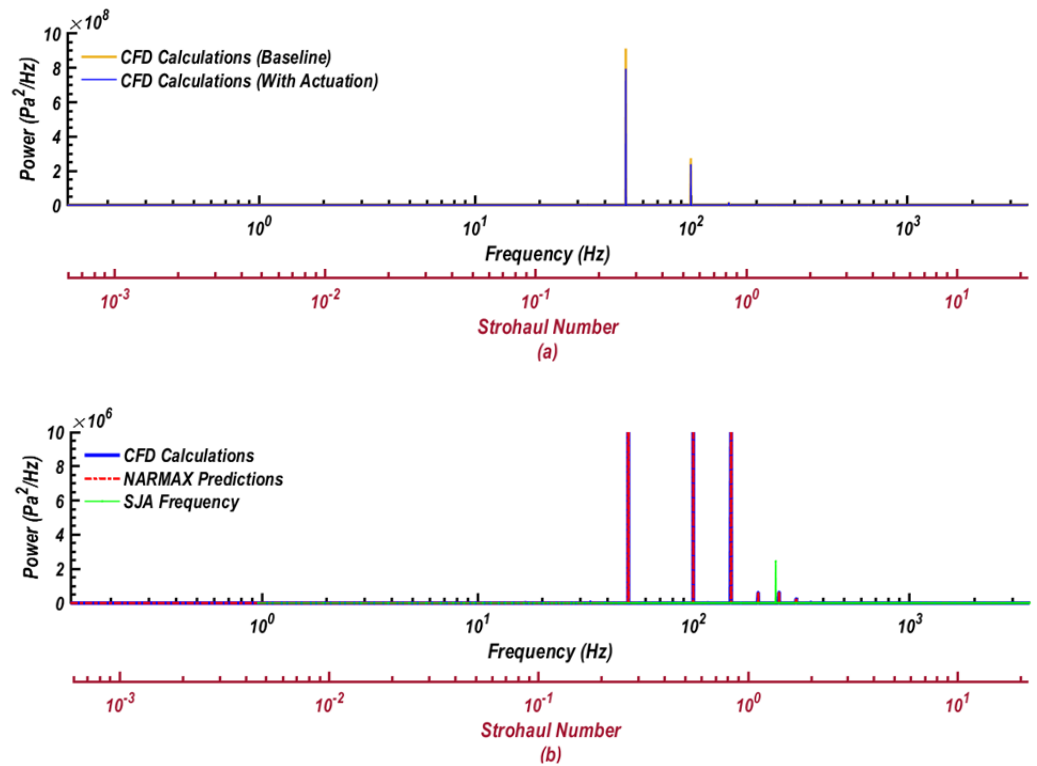
Figure 10. Comparison of the power spectra of pressure signals. ( a ) Baseline flow (uncontrolled) and controlled flow with jet actuation at the frequency of 250 Hz. ( b ) CFD pressure signal and NARMAX estimated pressure signals with the jet driving frequency at 250Hz.